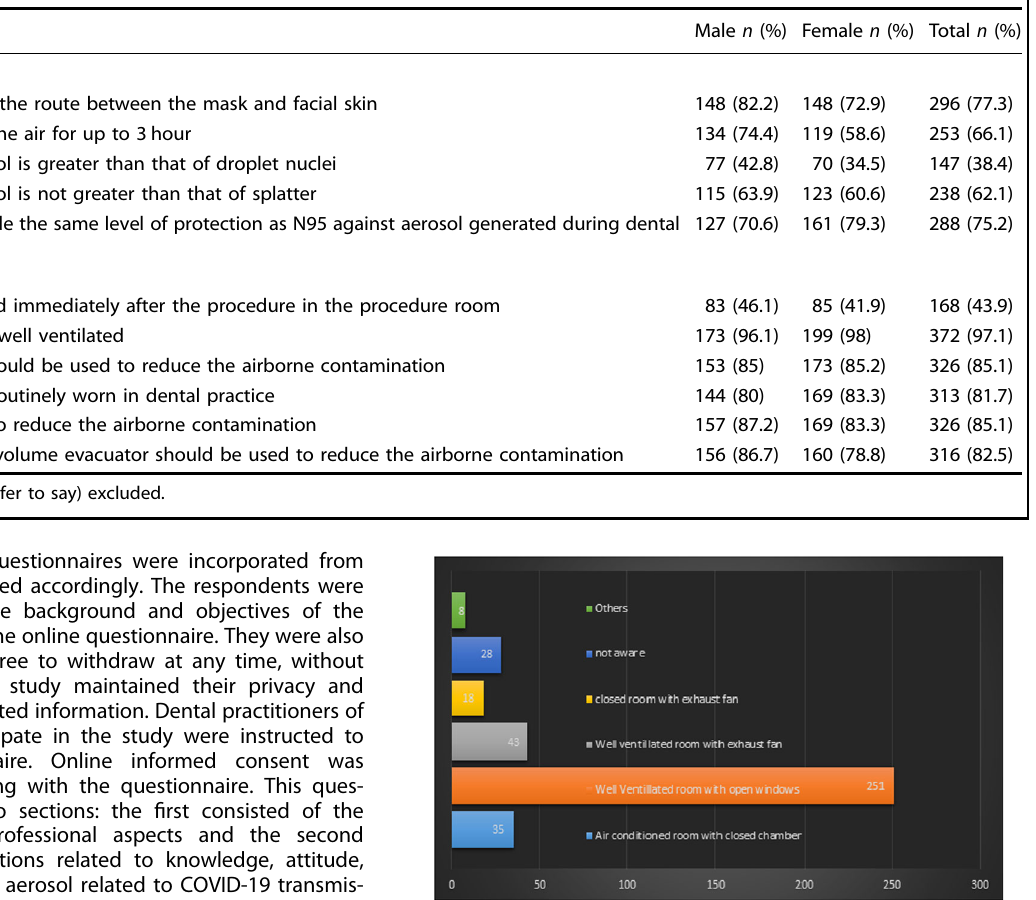
Table 3. Distribution of participants regarding correct responses for knowledge and attitude related to the aerosol transmission of COVID-19.